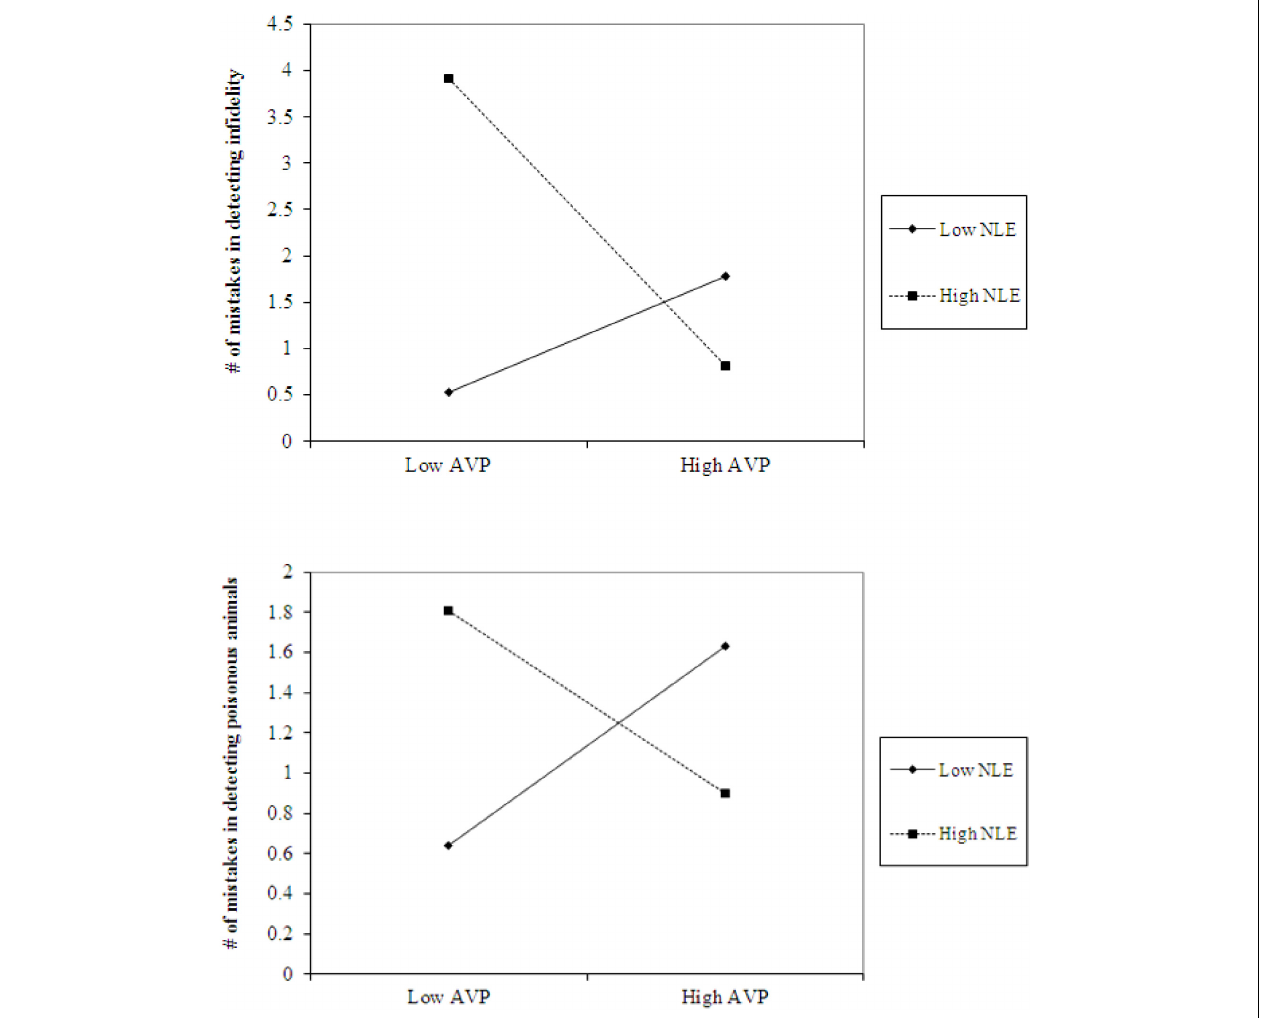
FIGURE 4 | Accuracy in detecting infidelity (top panel) and poisonous animals (bottom panel) as a function of AVP and early life stress (NLE). High AVP was linked with higher accuracy in detecting infidelity (i.e., fewer mistakes) and poisonous animals among people with high early life stress (i.e., better ability to detect various threats) but with lower accuracy among people with low early life stress and, thus, safer environment (i.e., lower vigilance to